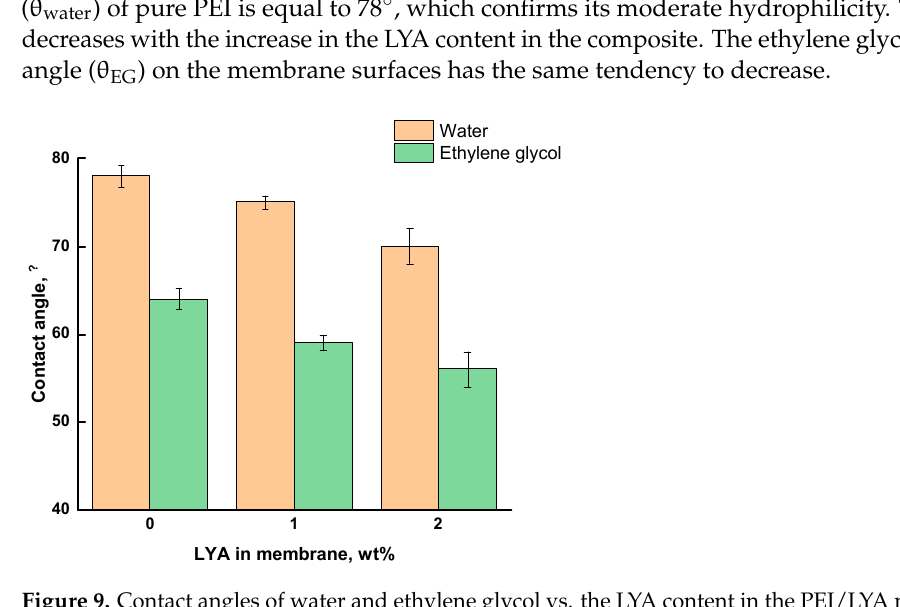
Figure 9. Contact angles of water and ethylene glycol vs. the LYA content in the PEI/LYA mem ‐ brane.